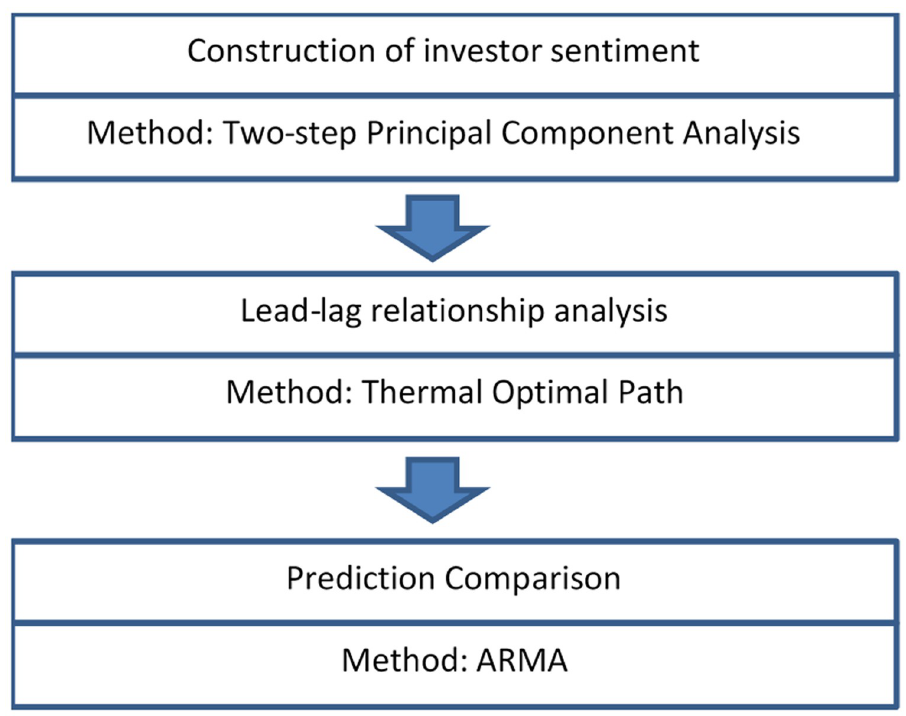
Fig 1. Flow chart for this